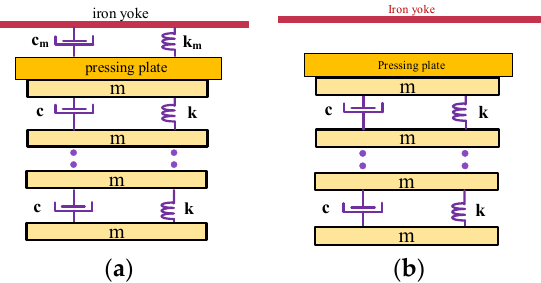
Figure 1. Mass–spring–damping equivalent model. ( a ) Normal model. ( b ) Pad falling